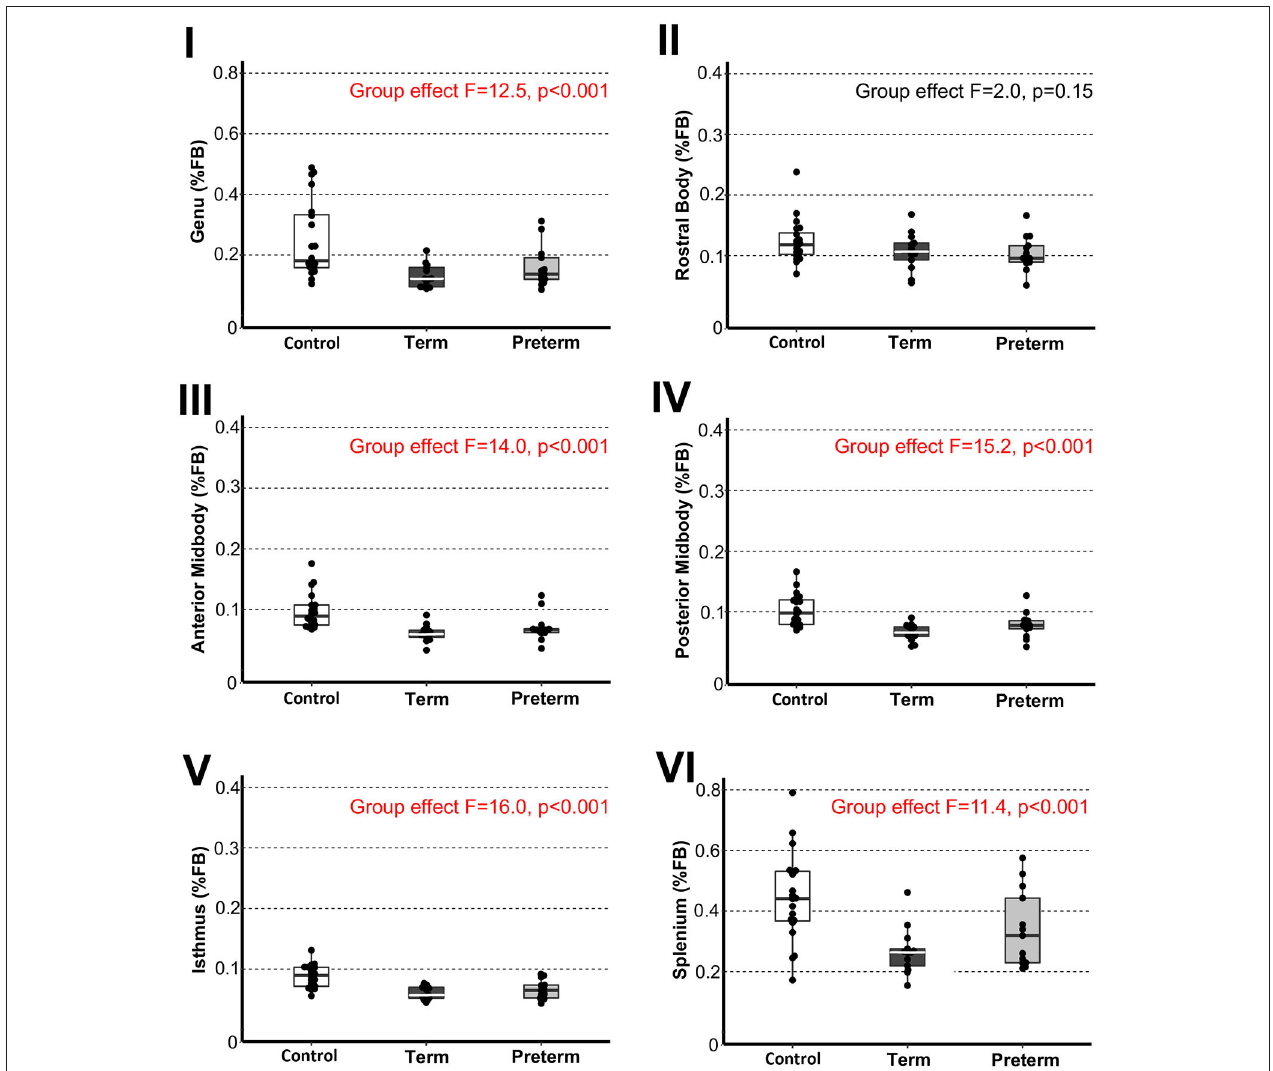
FIGURE 3 | Sub-regional corpus callosum volumes. Graphs display individual normalized sub-regional volumes as a % total forebrain (FB) volume for the three study groups: (1) term-born controls ( n = 20; white box), (2) term-born patients ( n = 13; black box), and (3) preterm-born patients ( n = 13; gray box). As noted in Methods section, forebrain volume used for normalization was not available for 1/21 controls due to incomplete brain coverage, which accounts for final control group n = 20. Normalized volumes as % FB of all CC sub-regions, except for the rostral body, were significantly smaller in both term-born and preterm patients compared to controls ( p ≤ 0.002; Table 2 ), but not between patient groups. Dots represent individual data values, boxes represent the interquartile range (25–75%), and solid horizontal lines represent medians. Roman numerals for each graph also depict classification of CC sub-regions as outlined in the Figure 1